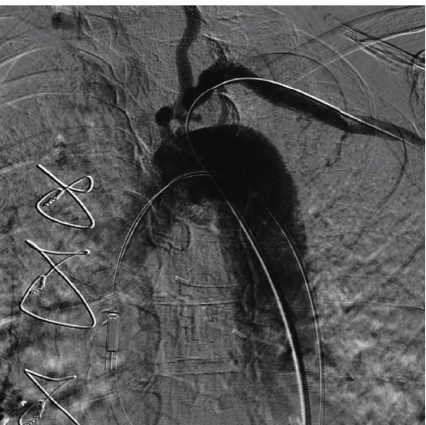
Figure 6: TIMI 3 flow with no residual stenosis after stenting of subclavian